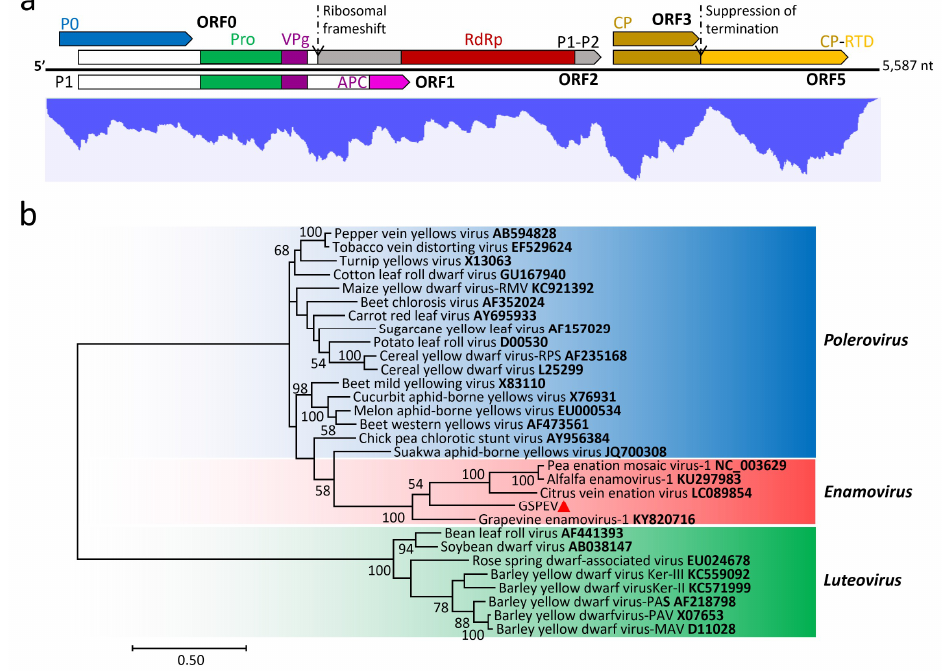
Figure 4. ( a ) Genomic structure of green Sichuan pepper-enamovirus (GSPEV) and profile distribution of transcriptomic reads from GSPEV. The colorful blocks in proteins represent conserved amino acid sequences, domains or motifs. P0, P1 and P1-P2 are the protein names. Pro: Proteinase. Hel: